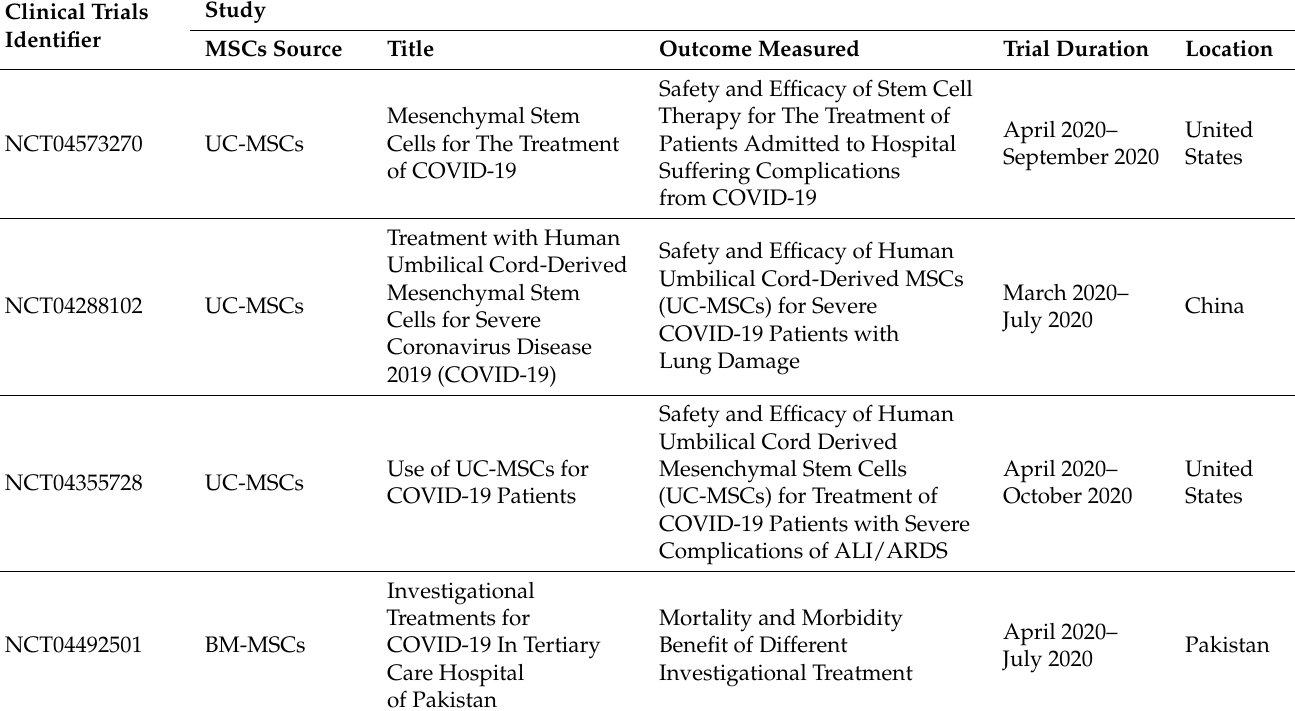
Table 4. Completed clinical trials of MSCs usage for the treatment of